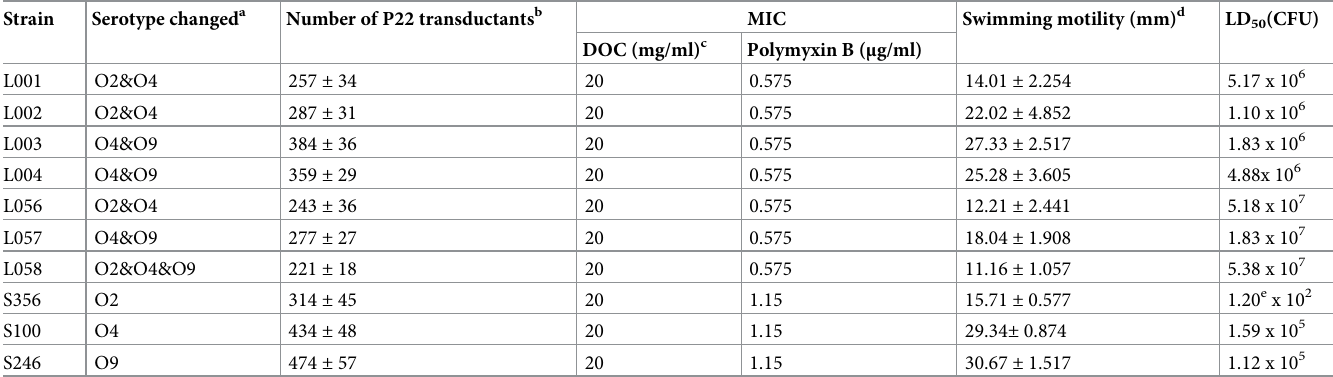
Table 3. Transduction efficiencies, MIC of DOC and Polymyxin B, swimming motility and virulence of wild type Salmonella and its derivatives. Strain